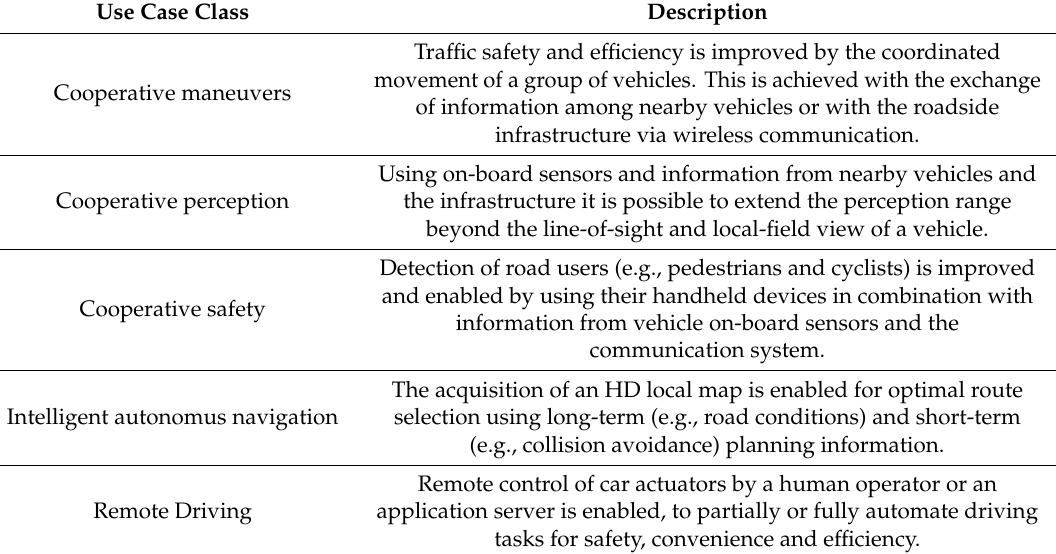
Table 1. Brief description of 5G Communication Automotive Research and innovation (5GCAR) use